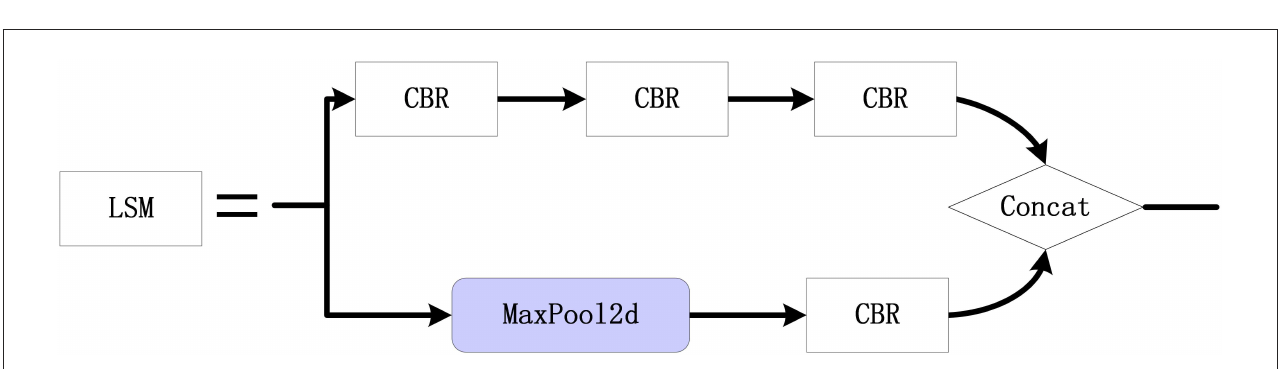
FIGURE6 LSM module